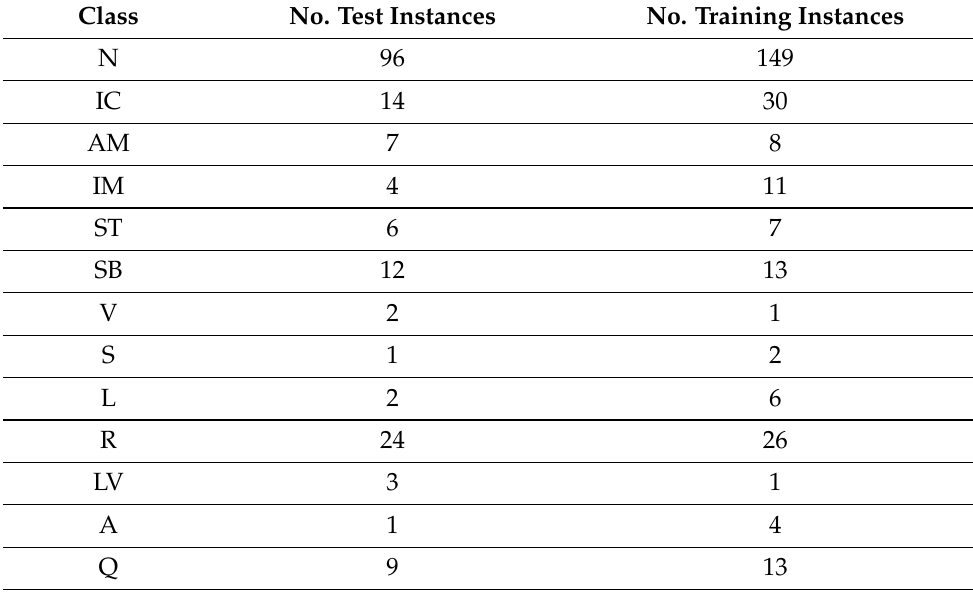
Table 6. Training and Testing Data Division—D1.